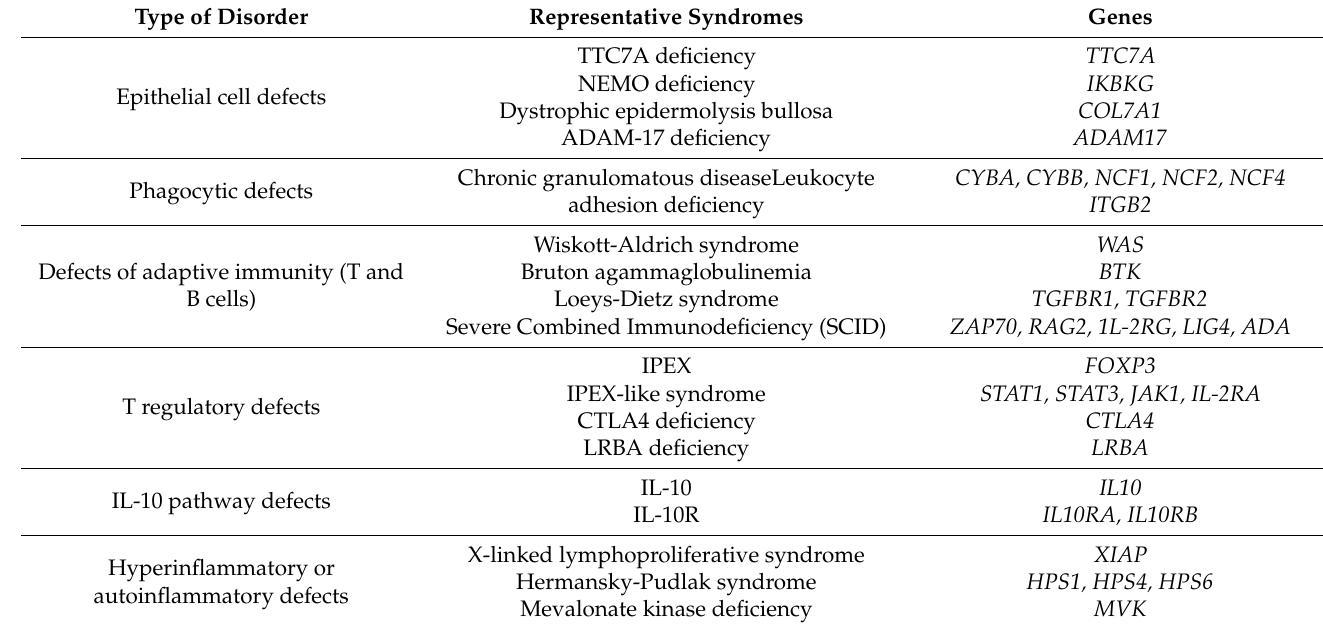
Table 1. Summary of monogenic etiologies of